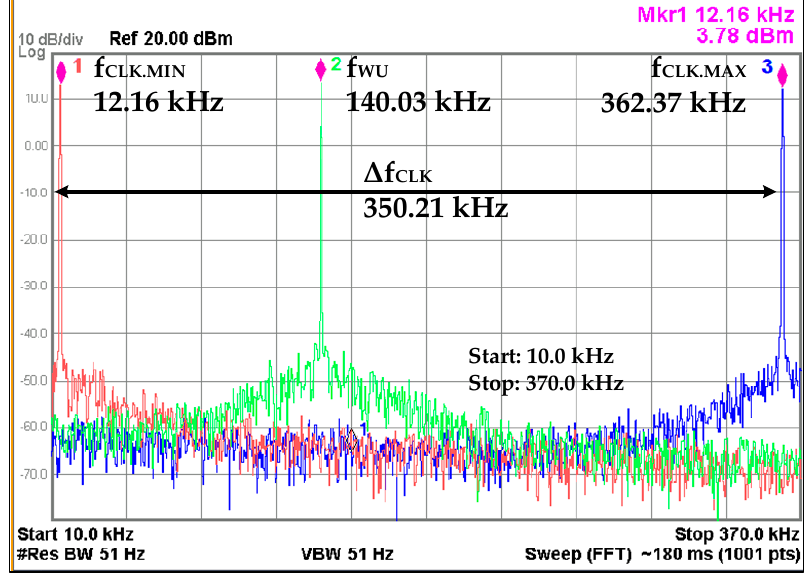
Figure 19. Oscillator (OSC) frequency range and measurement result.